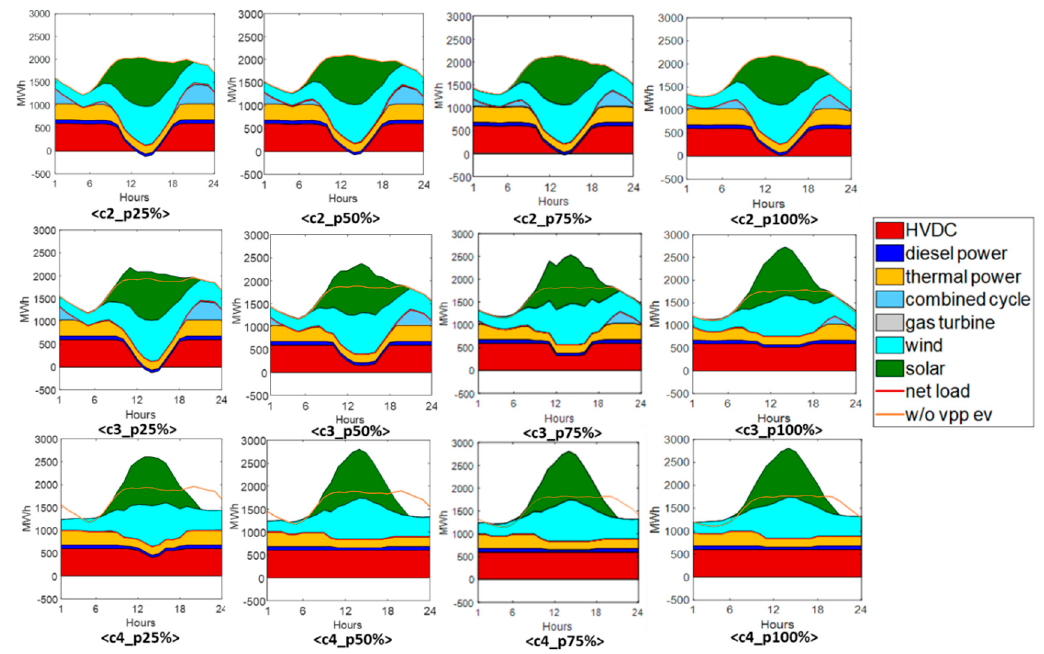
Figure 13. Expected 24-h dispatch profiles for varying EV participation rates in 2030. Table 9. Monthly net cost saving per EV by varying participation rates (USD /